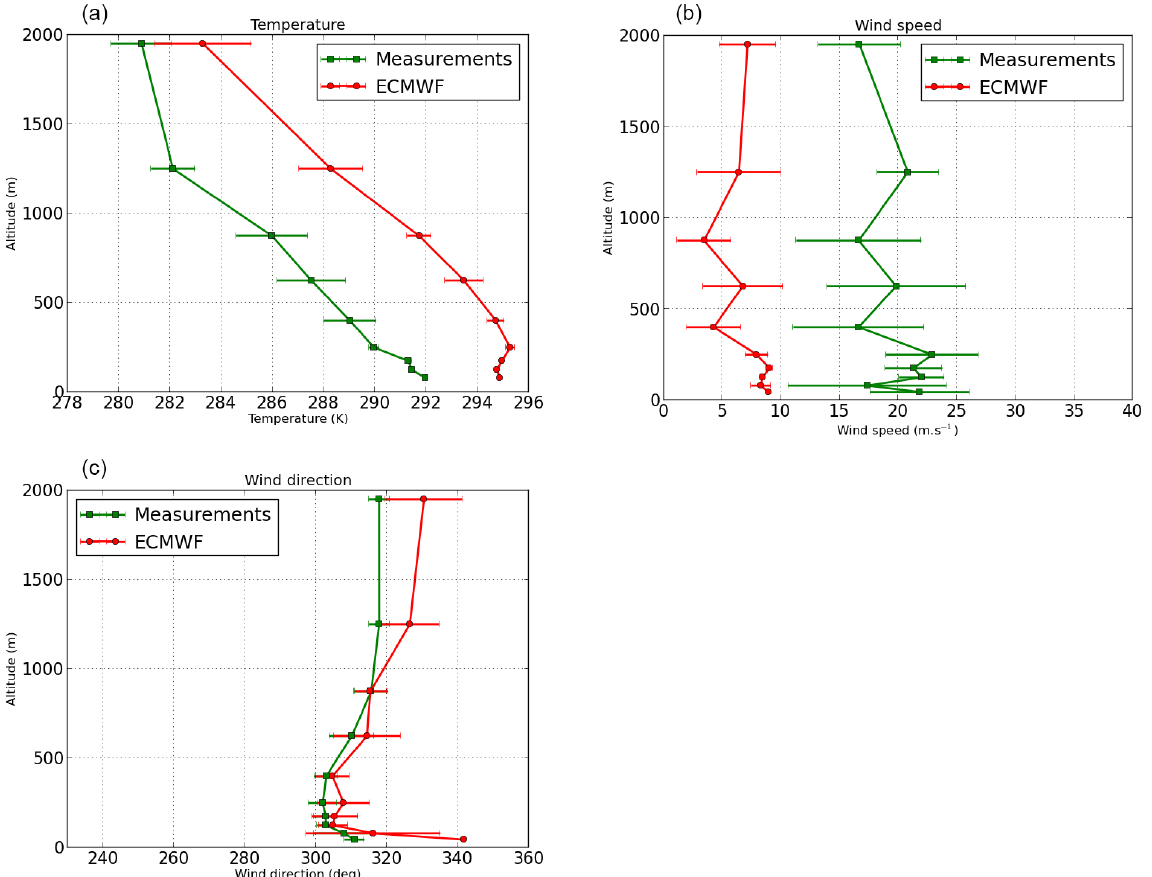
Figure F1. Comparison of temperature (a) , wind speed (b) and wind direction (c) during the flight on 10 July